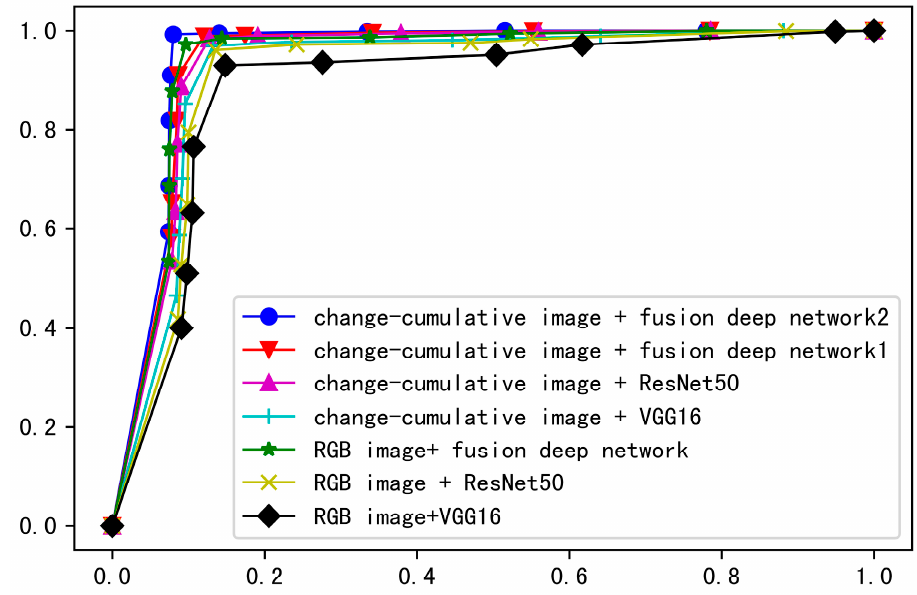
Figure 7. ROC curves with different input images and network models.